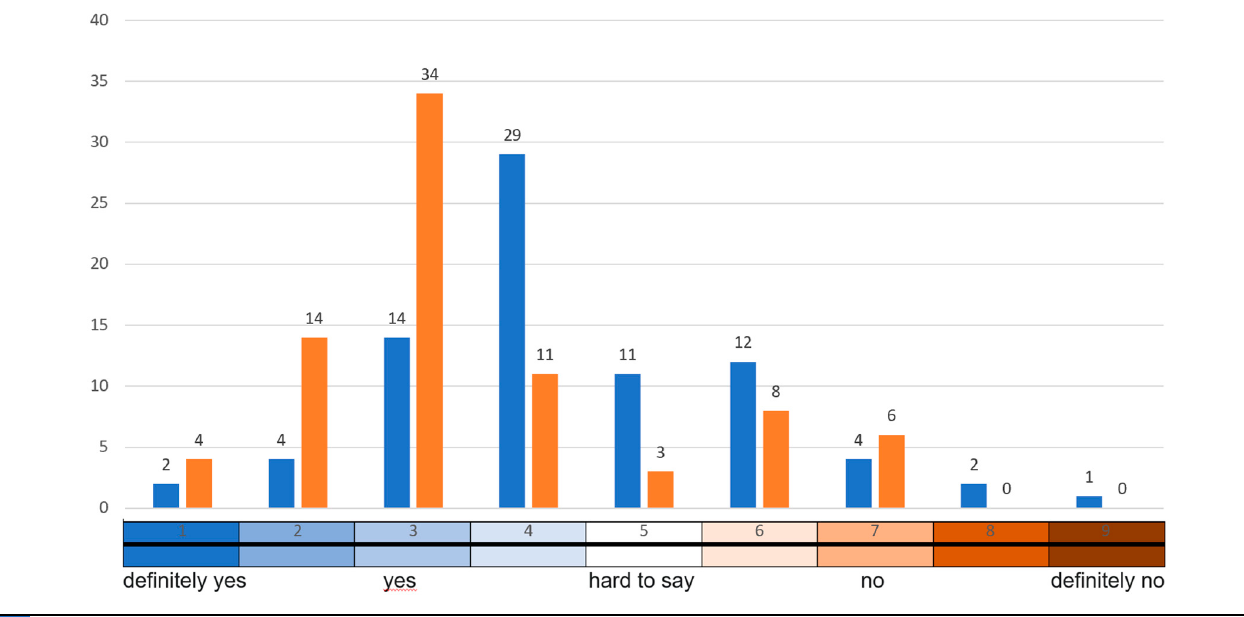
Figure 9. Results of test B—consumer tests on a nine-degree scale of material acceptance.